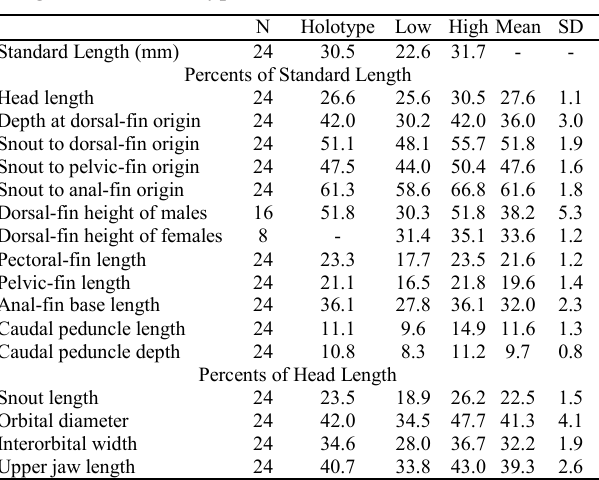
Table 1. Morphometric data of Hyphessobrycon peugeoti new species from rio Juruena drainage, based on holotype (MNRJ 38988) and paratypes (MNRJ 29503, 1 ex.; MNRJ 29521, 2 ex.; MNRJ 29609, 10 ex; MZUSP 77134, 8 ex.; ANSP 190999, 1 ex.; ZUEC 6362, 1 ex). N = sample size; SD = Standard deviation. Range includes